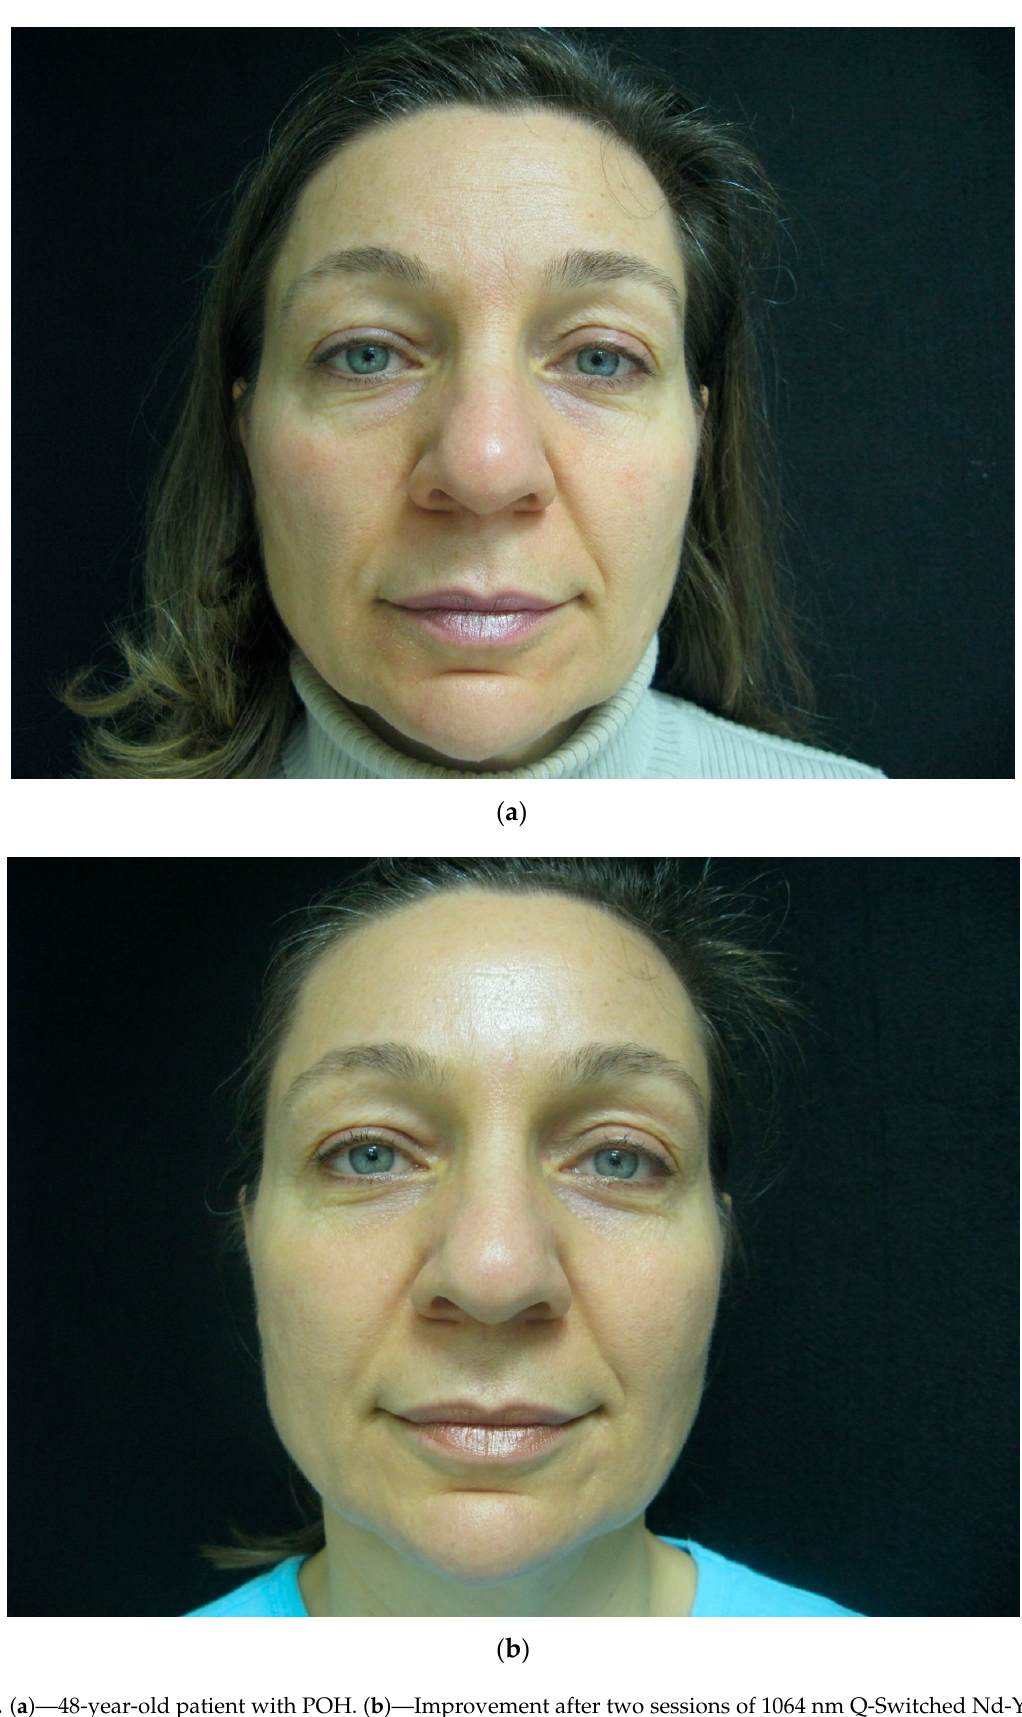
Figure 2. ( a )—48-year-old patient with POH. ( b )—Improvement after two sessions of 1064 nm Q-Switched Nd-YAG laser.